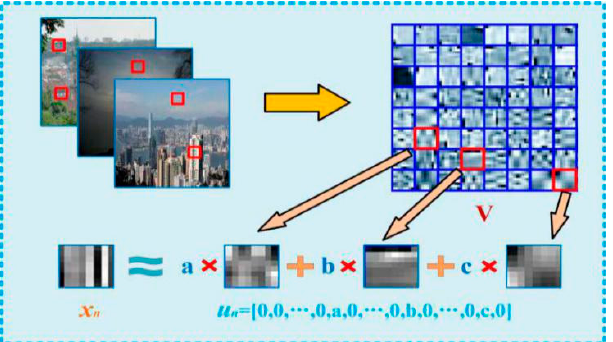
Figure 5. Dictionary training.